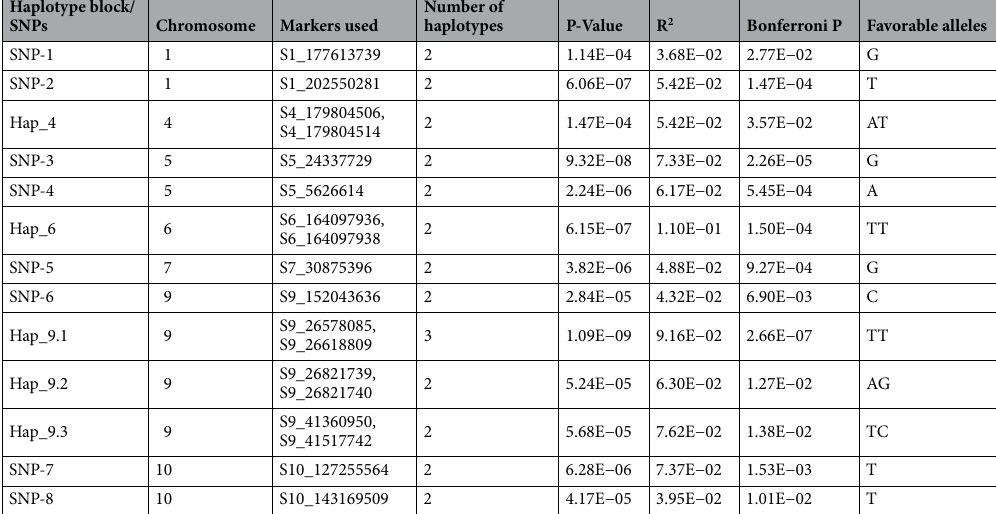
Table 4. Trend regression analysis using significant SNPs and haplotype blocks for grain yield under heat stress conditions.